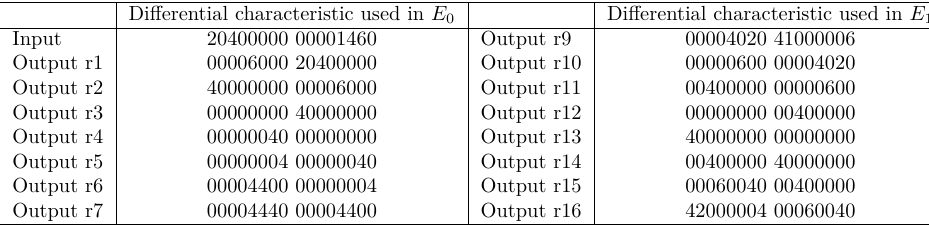
Table 3: The two differential characteristics on 7 rounds of E 0 and of E 1 in hexadecimal notations.